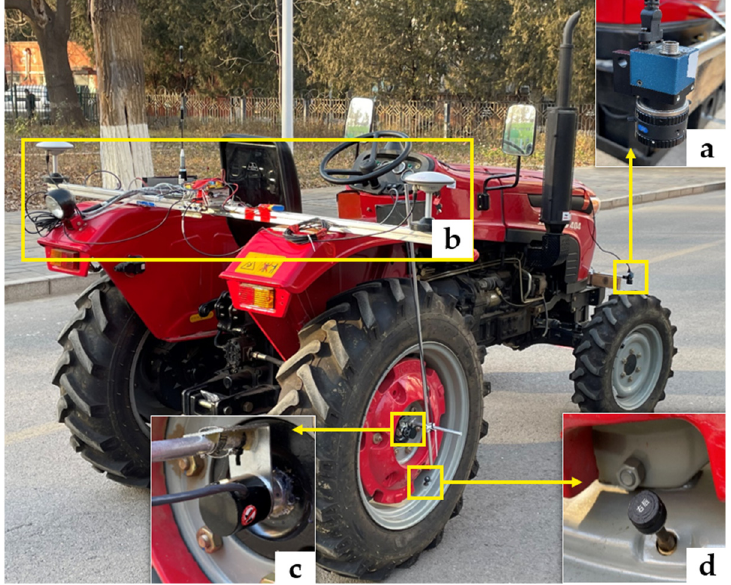
Figure 8. The experimental tractor is equipped with sensors. In this figure, ( a ) is a monocular camera, ( b ) are GPS antenna receivers, ( c ) is a rotary encoder, and ( d ) is a tire pressure monitor.